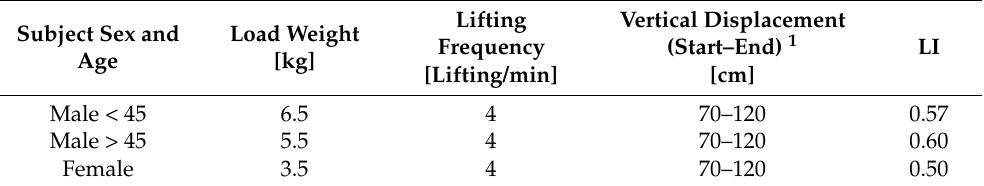
Table 2. Calculation of LI < 1 as a function of sex, age, load weight, lifting frequency and vertical displacement according to the RNLE.